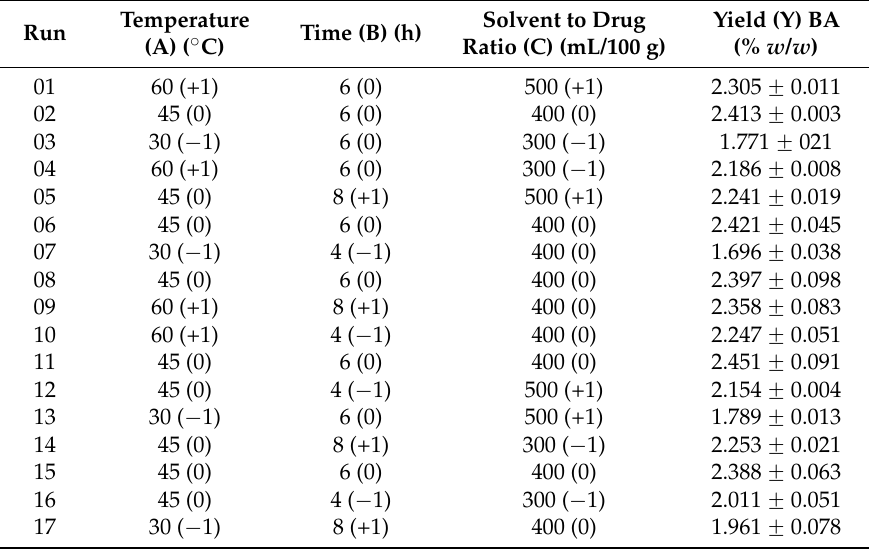
Table 5. BBD Matrix for optimization of extraction of yield of BA.